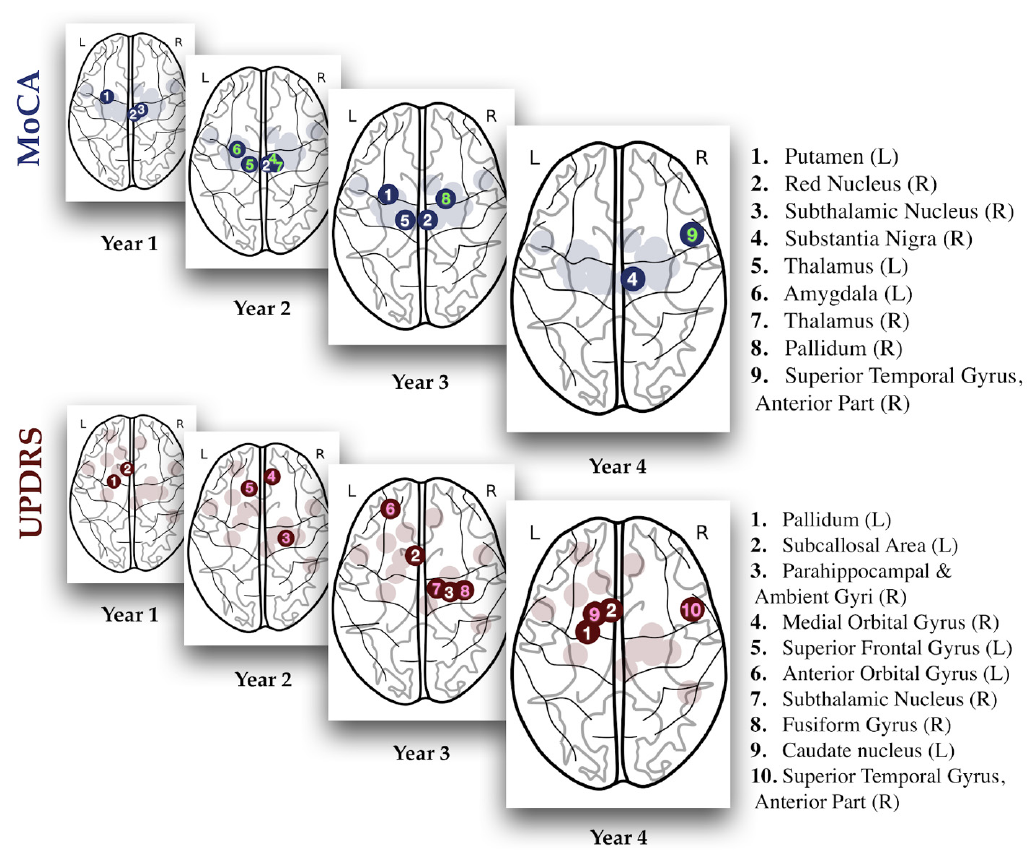
Figure 2. Emergence of distinct salient regions when predicting MoCA (top) and UPDRS (bottom) scores for different years. Numbered regions represent areas with relative saliency above a 4% threshold and are highlighted whenever they first appear, compared to the previous years. Shaded background regions correspond to the range of brain regions used as input for the neural network. A list of complete regions and their relative saliencies is shown in Fig. 3.